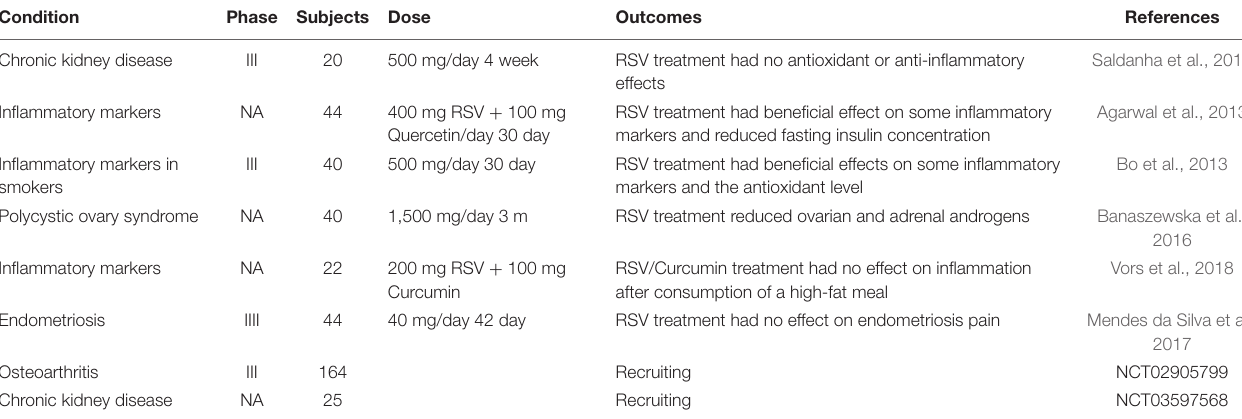
TABLE 6 | Clinical trials of resveratrol for inflammatory diseases.